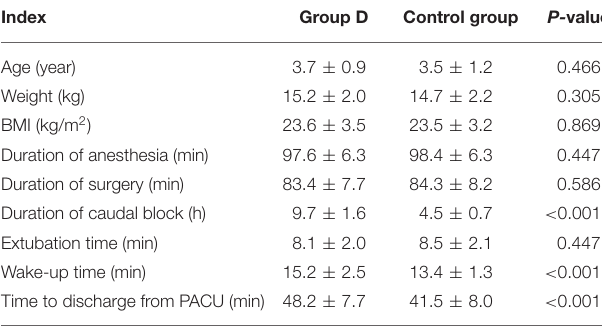
TABLE 1 | Data of children ( n =